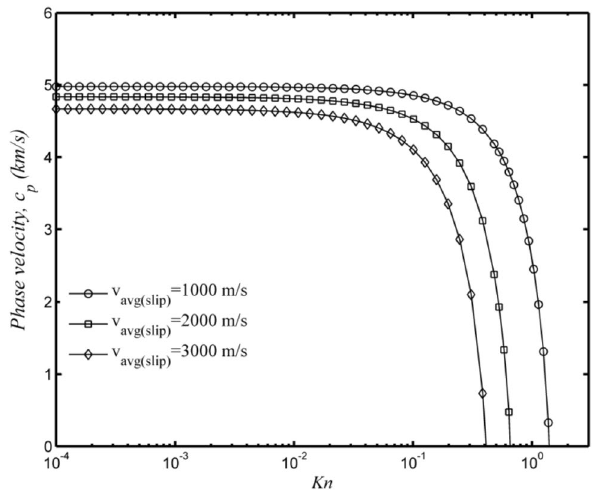
Fig. 3 The phase velocity against the wave number regarding magnetic fluid effect with v avg ( slip ) = 1000 m ∕ s , Kn = 0 .001 and B 0 = 50 T